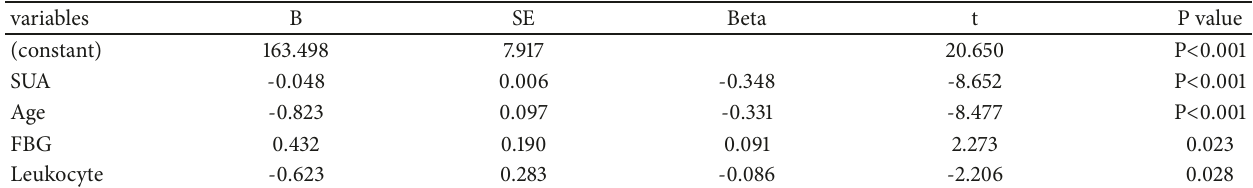
Table 6: Multiple linear stepwise regression analysis for association between eGFR and SUA in male